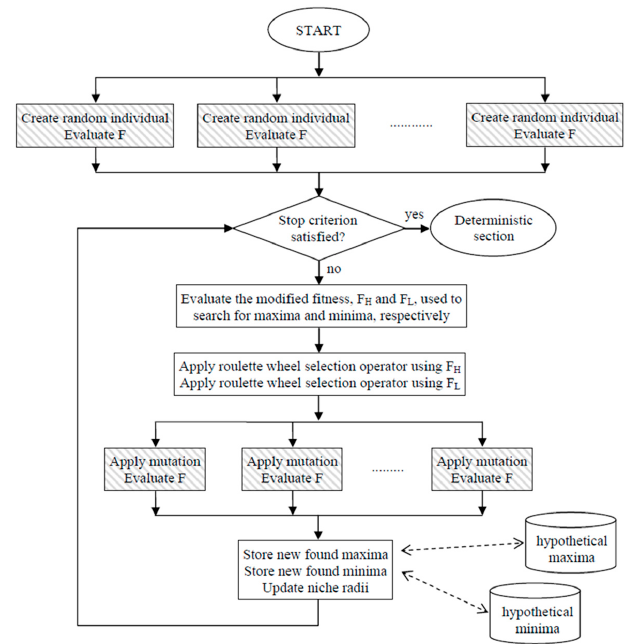
Figure 2. Main steps of the PSALHE-EA’s stochastic section. In the blocks filled with grey lines the